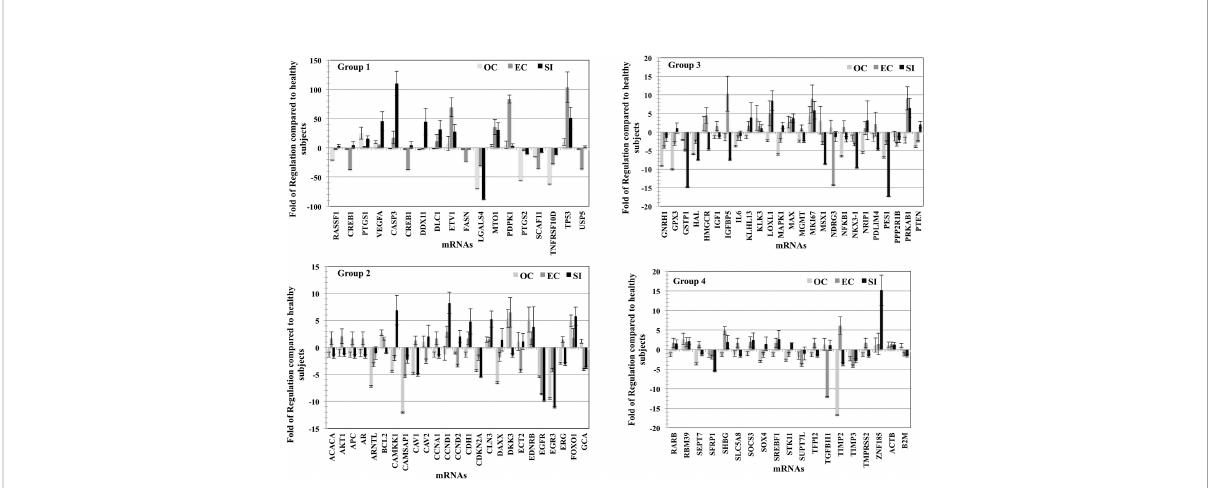
FIGURE 4 mRNA pro fi le of plasma vesicles showing the folds of regulation in expression of speci fi c mRNAs compared to healthy subjects. Three plasma samples from each of the three PC tumor types (OC, EC, and SI) were compared to three healthy subjects, and the results were normalized to a set of control mRNAs included in the microarray. The four groups (histograms) have various regulation scales to differentiate between mRNAs that are moderately differentially expressed to those that are greatly differentially expressed. The p-values are calculated based on a Student ’ s t-test of the replicate 2^(- Delta Ct) values for each gene in the control group and tumor groups. Fold regulation values greater than one indicate positive or upregulation. The fold of regulation values less than one indicate negative or downregulation; the results were considered signi fi cant at p < 0.05; the results were presented as the mean ±